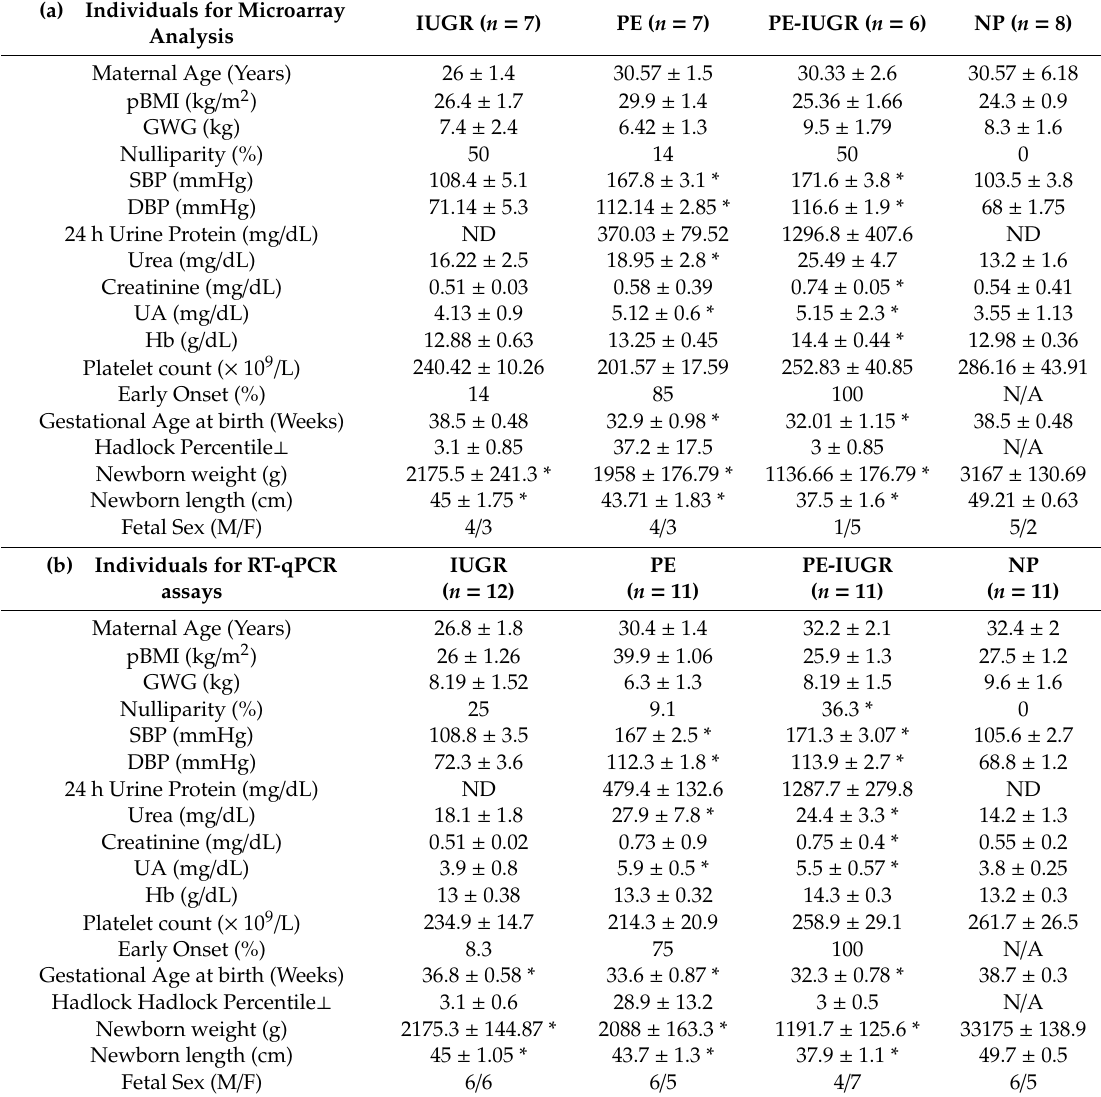
Table 1. Maternal and newborn Characteristics of study